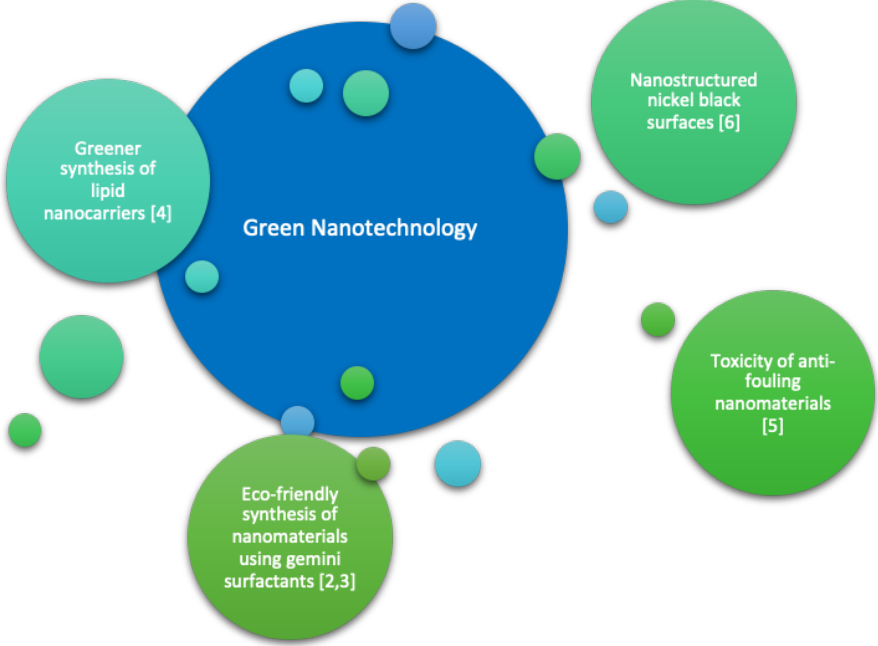
Figure 1. Main contributions of the present Special Issue to the field of green nanotechnology.